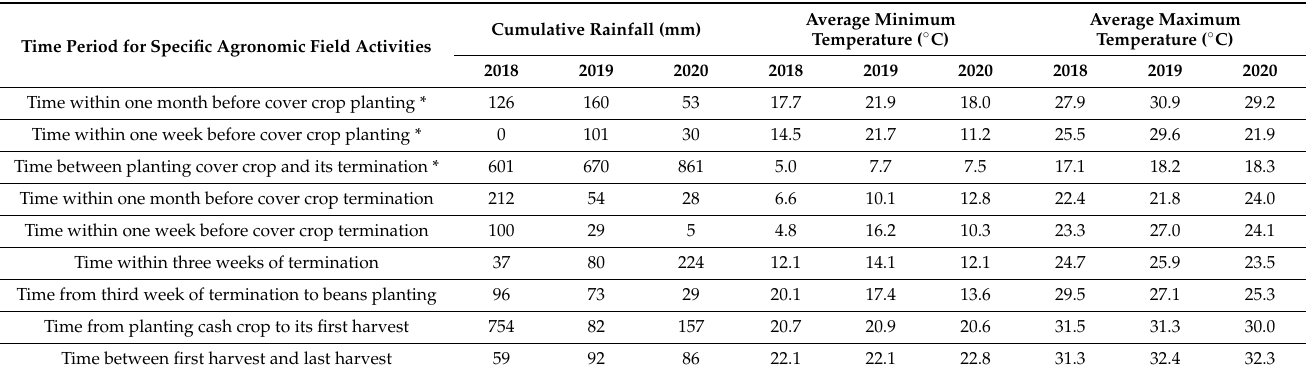
Table 2. Rainfall amounts and ambient temperatures (minimum and maximum) in each growing season during specified periods of agronomic field activities.